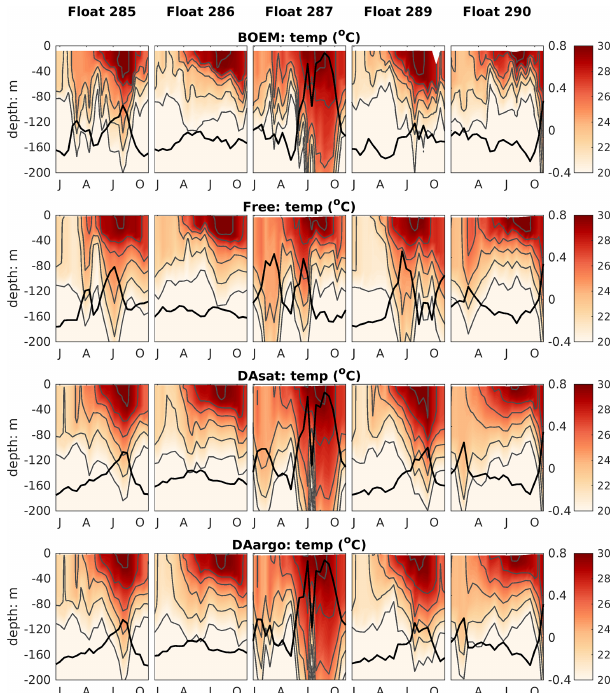
Figure 4. Vertical distributions of temperature from BOEM floats, the Free run, the DAsat run, and the DAargo run. Gray lines rep- resent isothermal lines with an interval of 2 ◦ C. Thick black lines represent SSH. The observed SSH is obtained from the matching record of altimeter